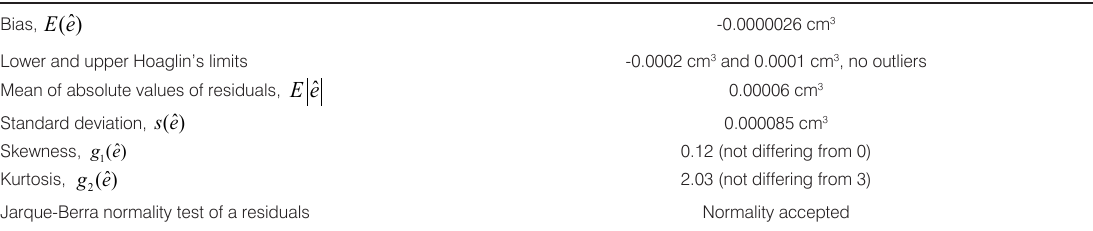
Table 1b. Reliability of parameter estimates proved by a statistical analysis of residuals Bias, -0.0000026 cm 3 Lower and upper Hoaglin’s